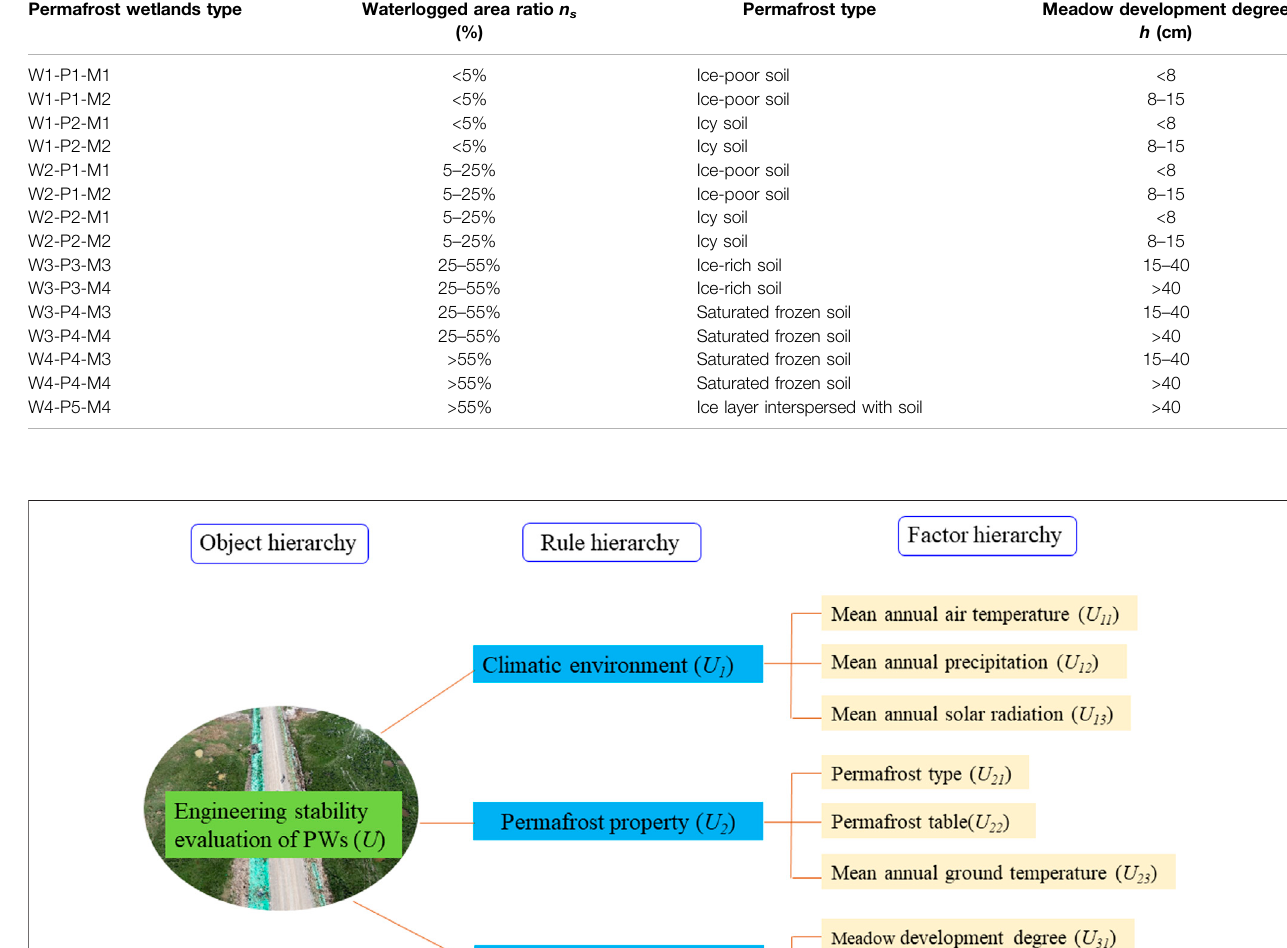
TABLE 3 | Classi fi cation of permafrost wetlands types. Permafrost wetlands type